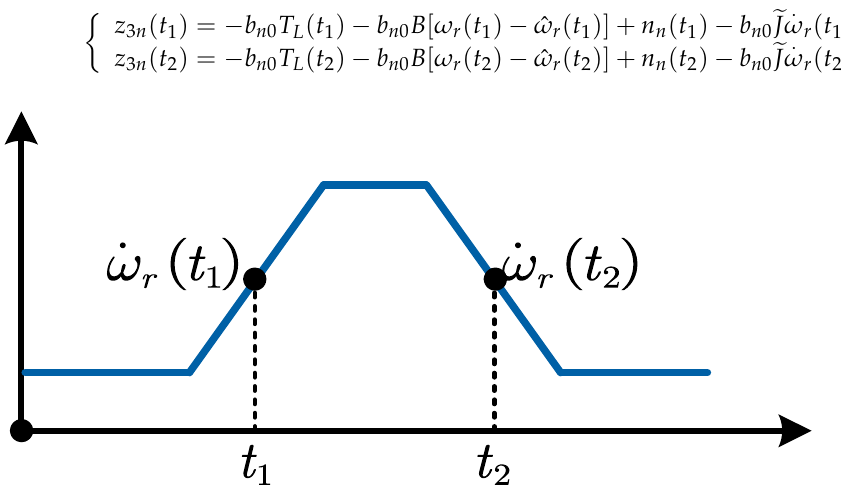
Figure 9. Required speed trajectory for inertia identification.